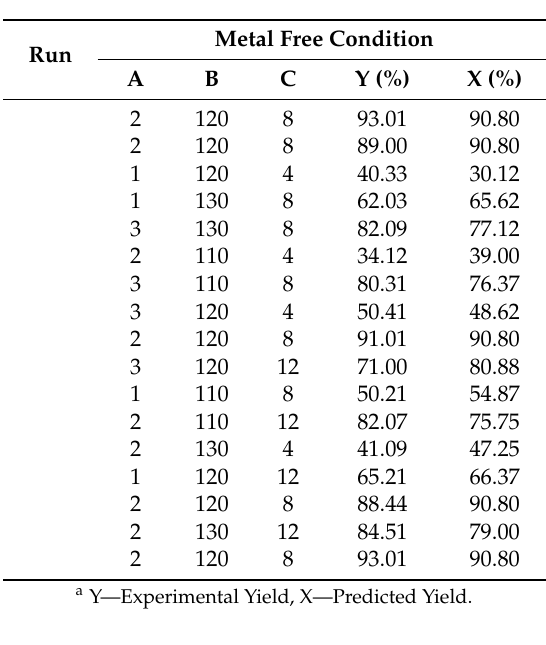
Table 3. BBD matrix response and its design a .